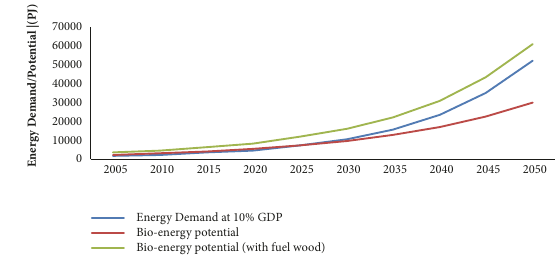
Figure 3: Comparison of energy demand at 10% GDP with the bioenergy